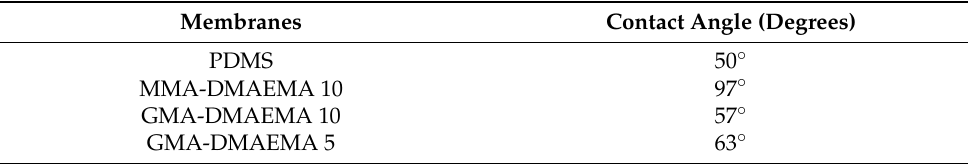
Table 2. Ultra-pure water droplet contact angle results on the four tested